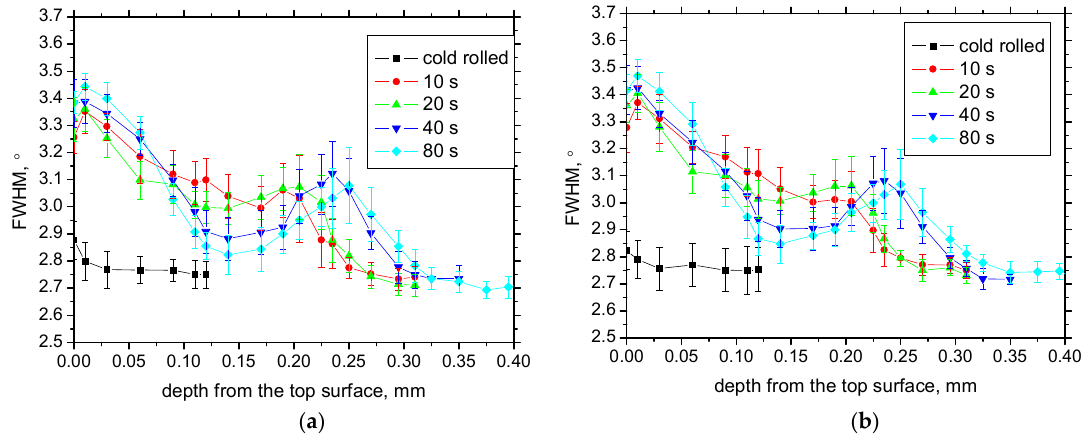
Figure 6. The full width at half maximum (FWHM) of XRD for the RD and TD directions. a ) RD direction, ( b ) TD direction.